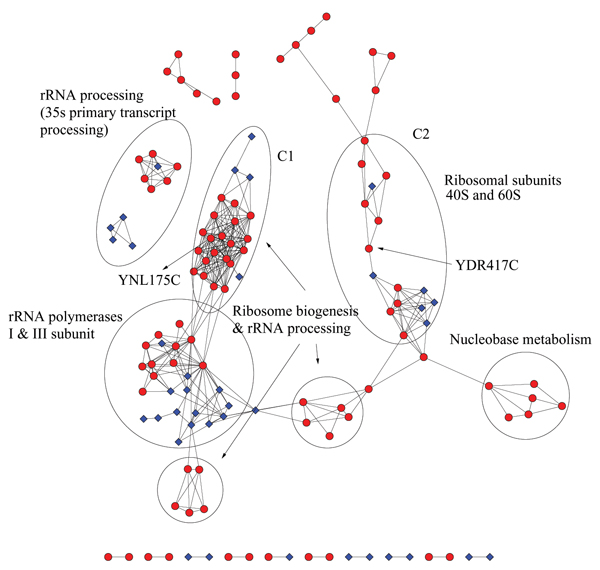
Cluster prediction. Predictions of protein-protein interactions in a cluster of 198 genes. Blue diamond-shaped nodes are proteins present in the training sample, red circle-shaped nodes were not seen by the learning algorithm. Annotation was found using BiNGO.